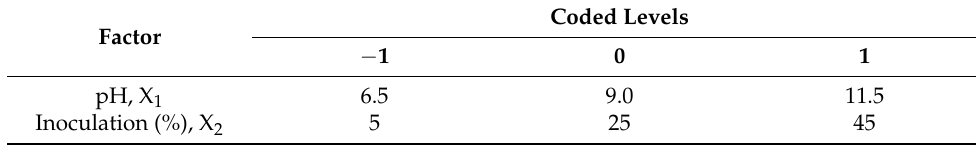
Table 3. Data for independent variables and their levels used in the experimental